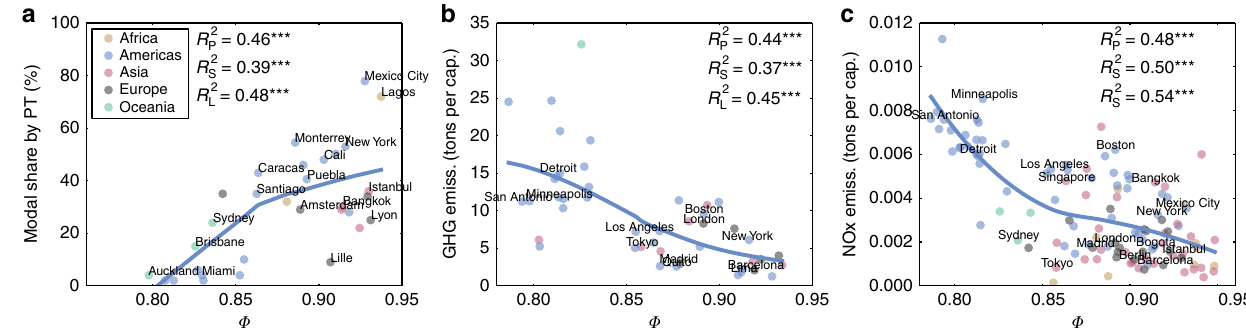
Fig. 5 Connecting Φ with urban indicators in worldwide cities. a – c Relation between, modal split, pollution and health in worldwide cities. a Modal share, b greenhouse gas emissions per capita in equivalent metric tons of CO 2 , c NO X emissions per capita